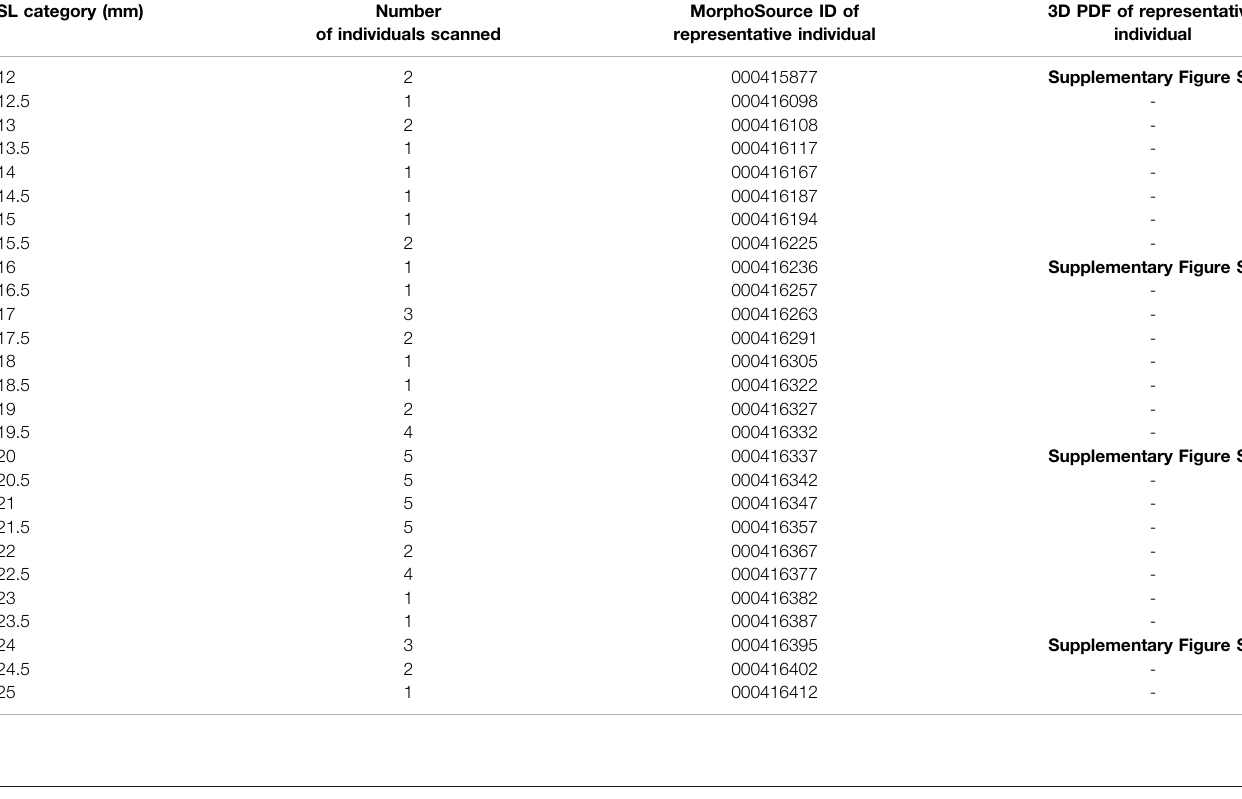
TABLE 1 | Categories of sizes, sample numbers and scan ID. Full details of each individual may be found in Supplementary Table S1 .